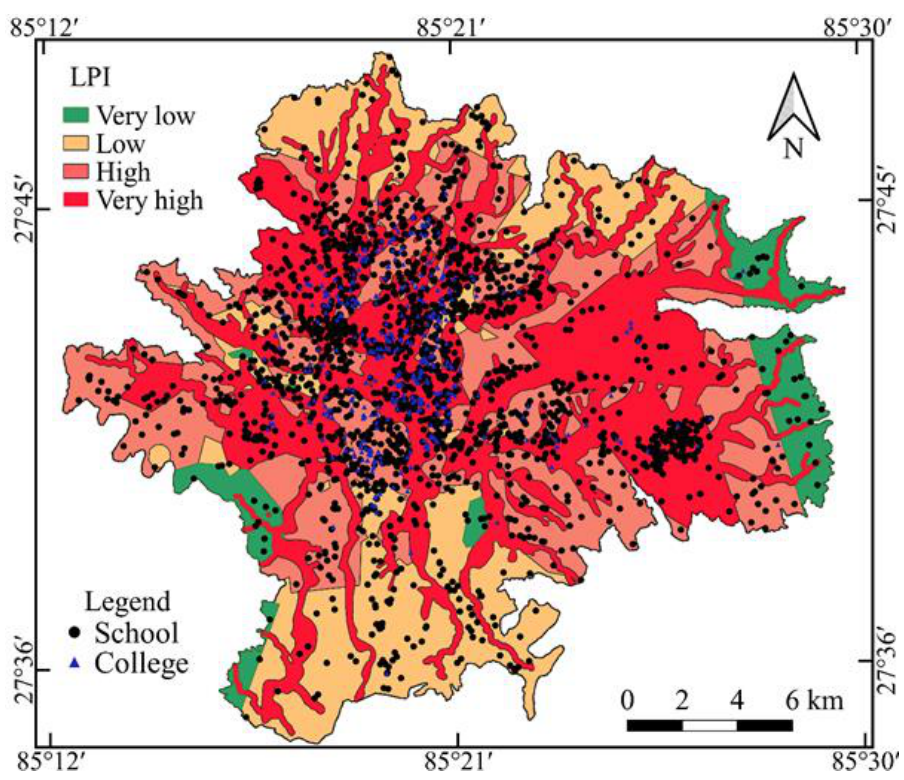
Figure 14. Liquefaction susceptibility map with schools and colleges of Kathmandu Valley.